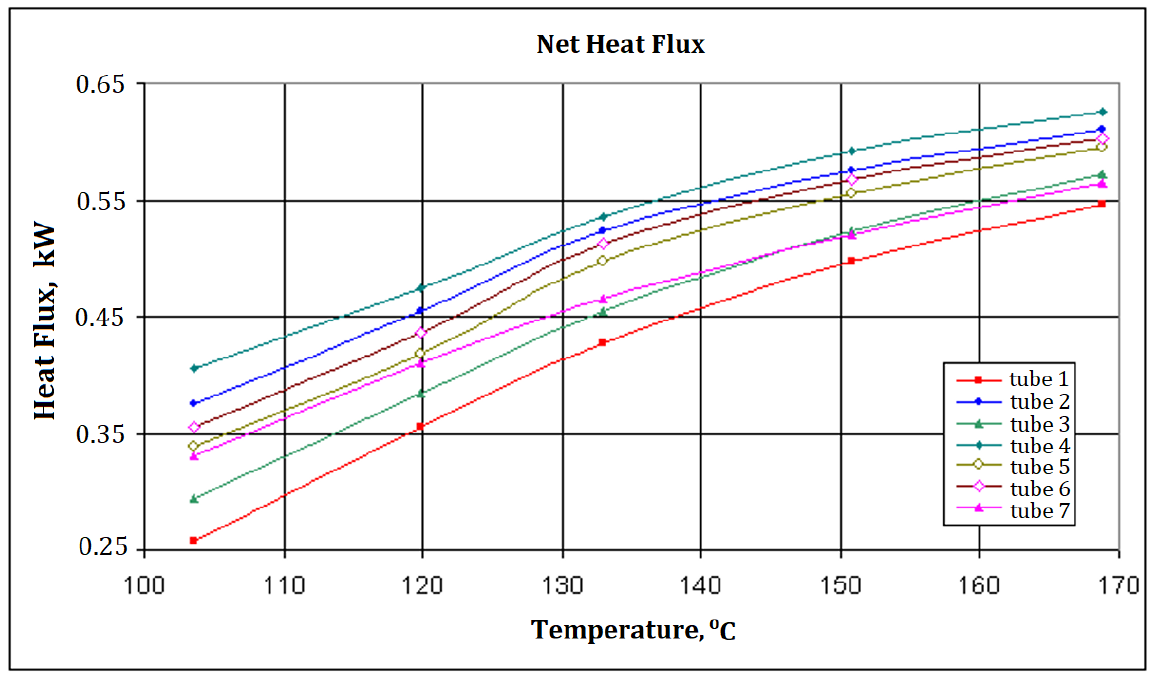
Figure 6. The “net” heat fluxes, i.e. , the heat fluxes transferred by the tested tubes to air, reduced by the heat flux transferred by the plain tube.